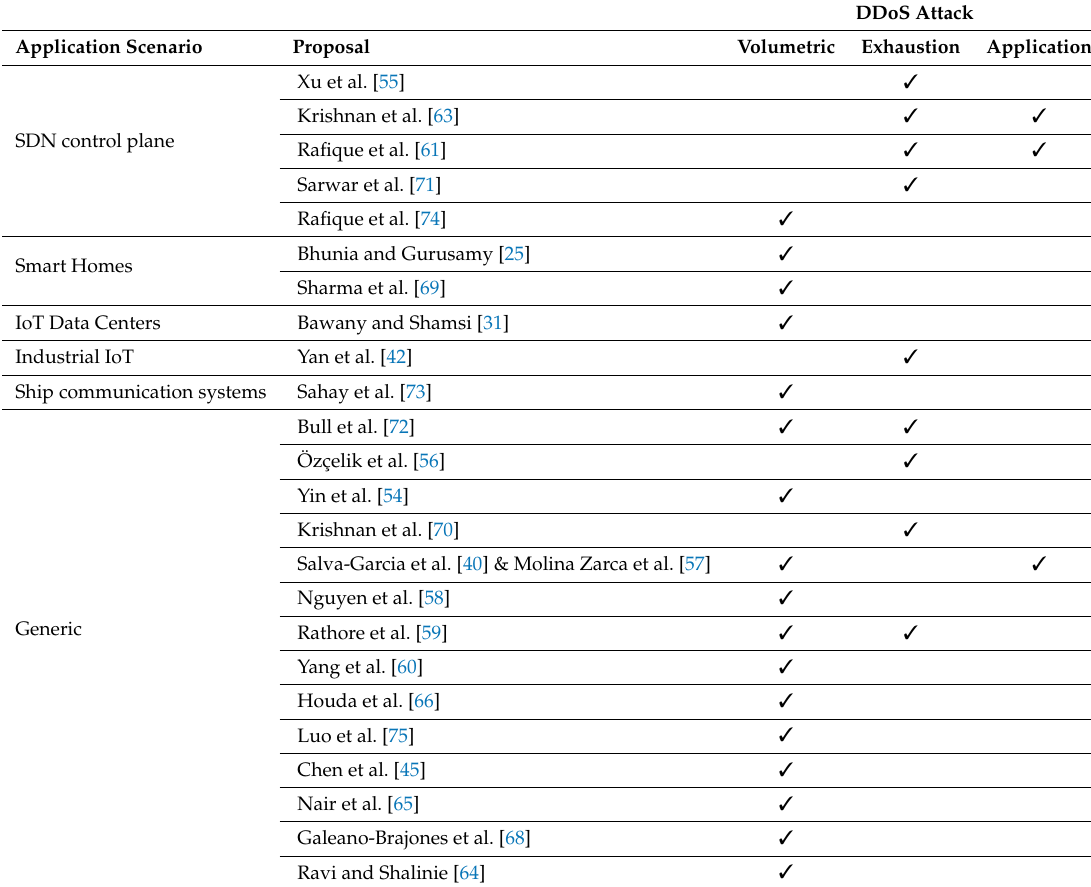
Table 4. Classification of mitigated Distributed Denial of Service (DDoS) attacks type by application